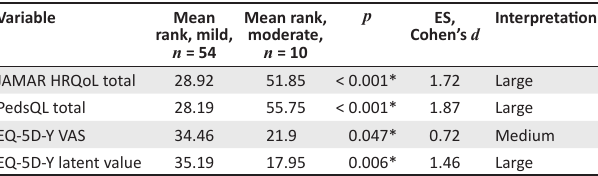
TABLE 3: Comparison of scores across the mild and moderate levels of disease severity.